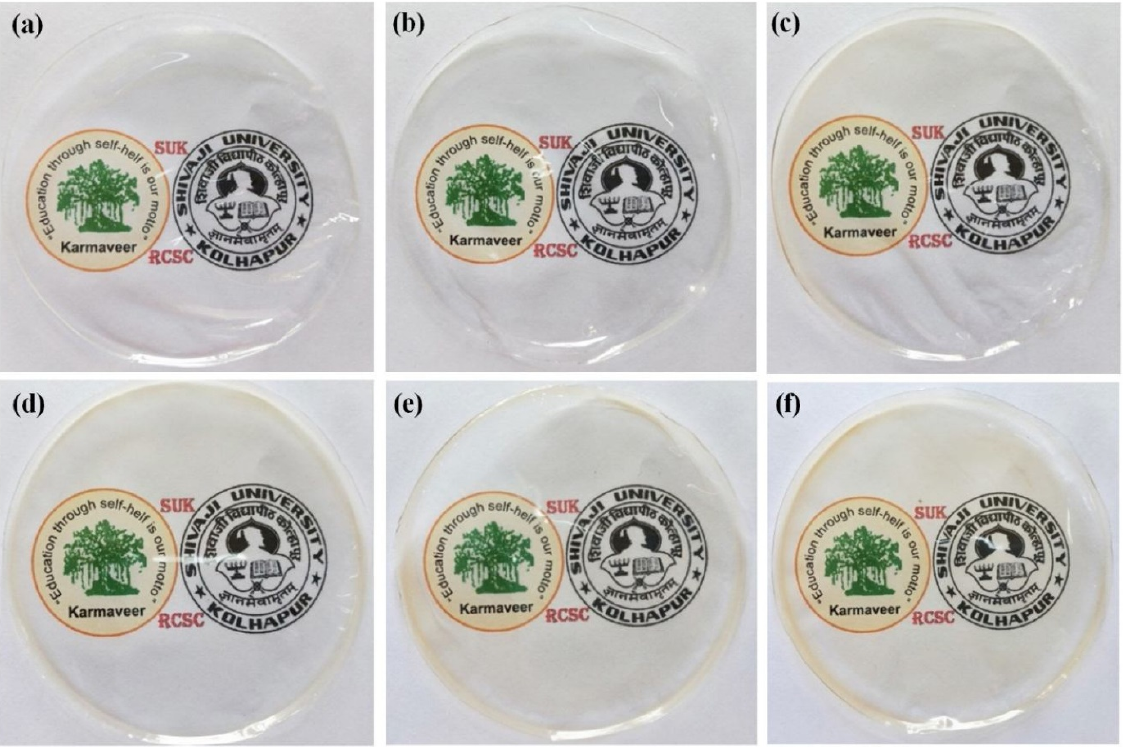
Figure 1. Photographic images showing the transparency of polyvinyl alcohol (PVA) film ( a ) and PVA/waste tea residue carbon dots composite films ( b – f ) with increasing concentration (0.5, 1.0, 2.0, 3.0, 5.0 mg) of waste tea residue carbon dots (taken from [6]).